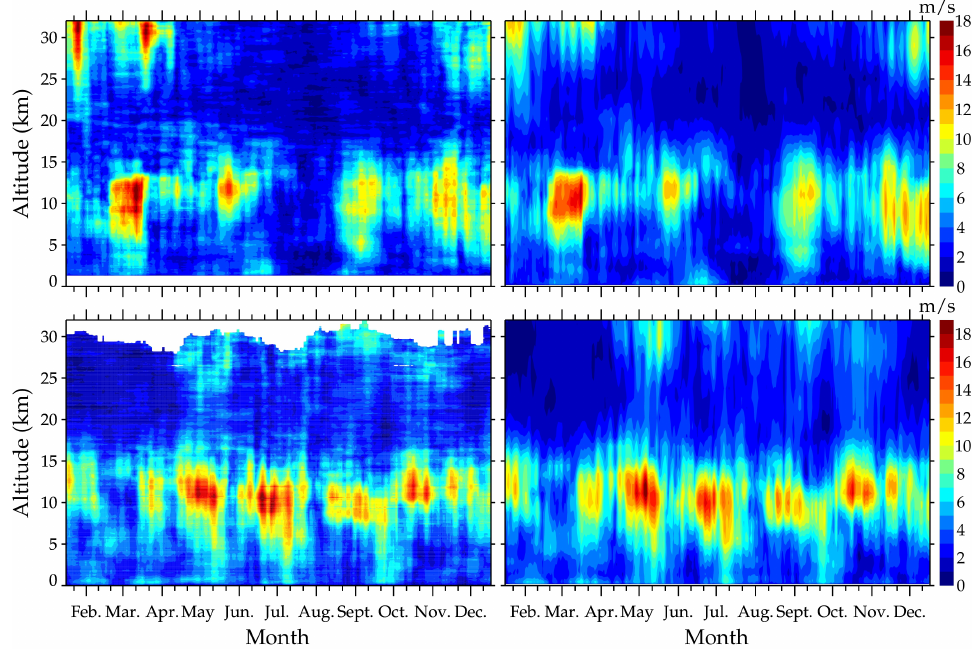
Figure 3. Zonal wind amplitudes of the 10DWs at Santa Teresa ( top row ) and Perth Airport ( bottom row ) deduced from the radiosonde observations ( left panels ) and MERRA-2 data ( right panels ) in